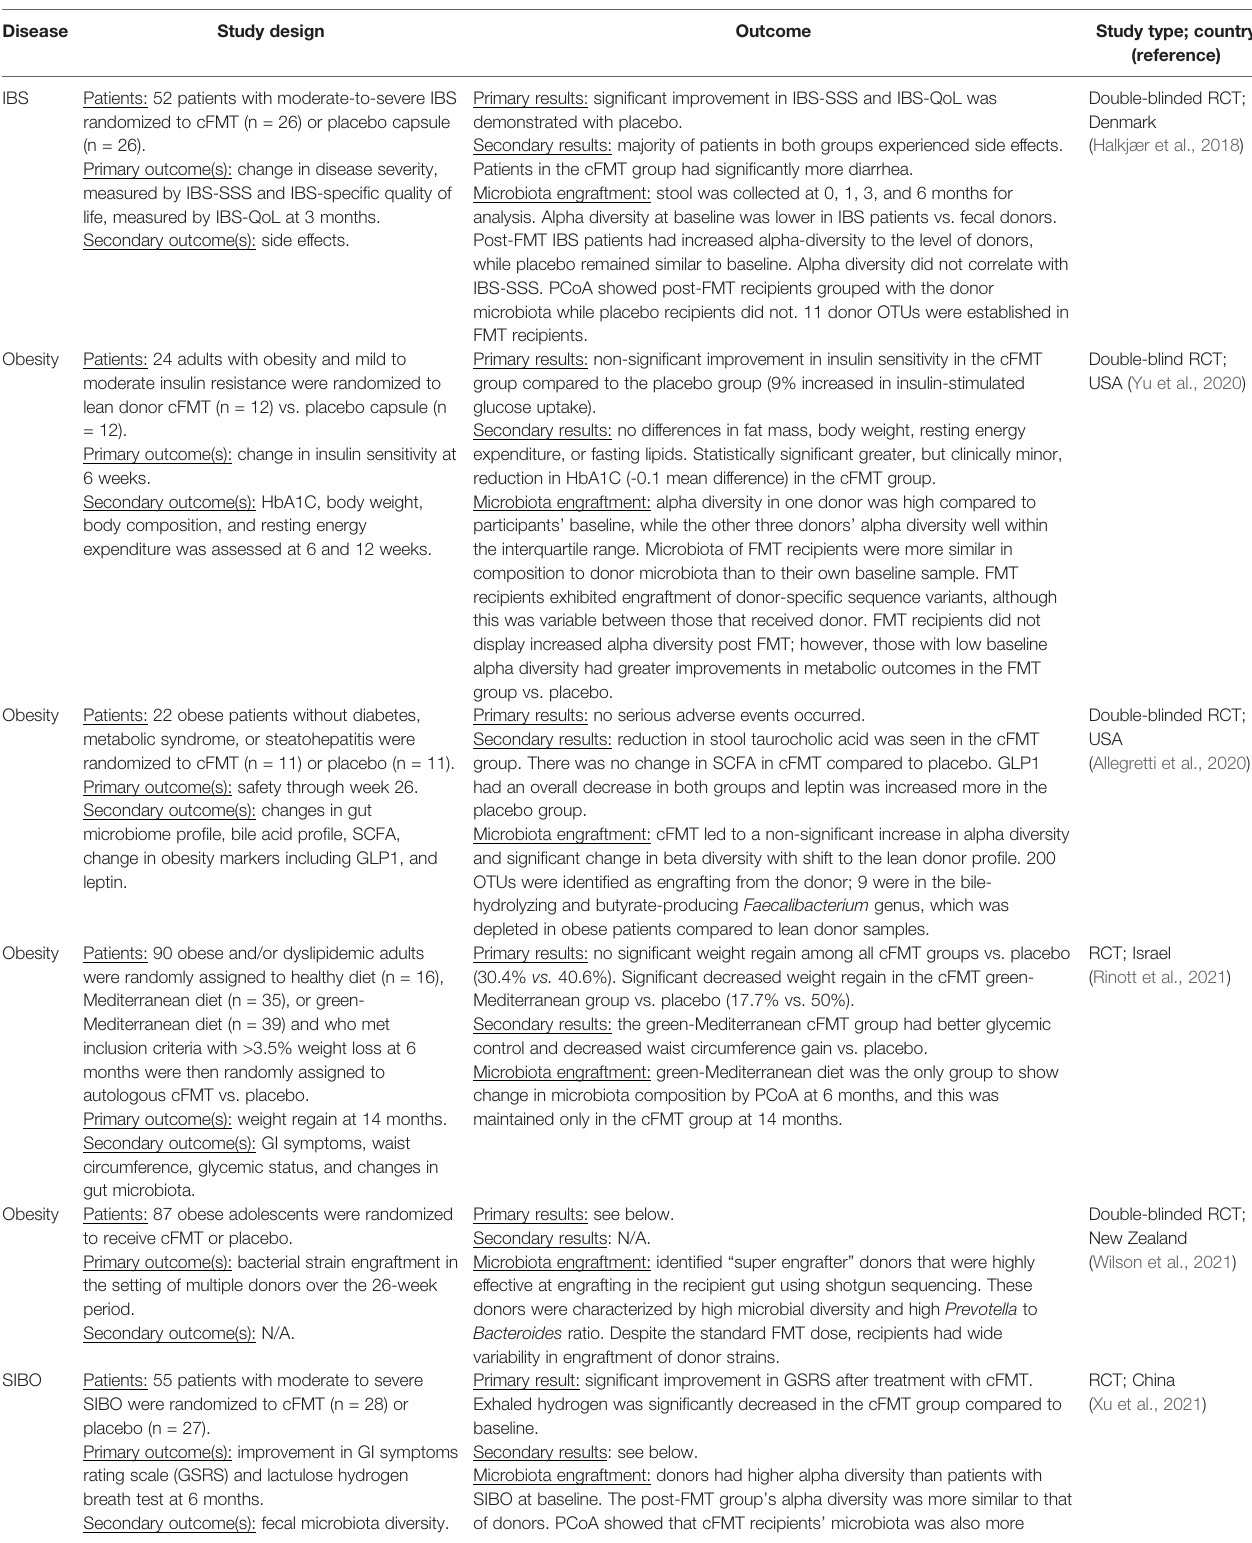
TABLE 3 | Summary of published cFMT clinical trials in non-rCDI diseases.